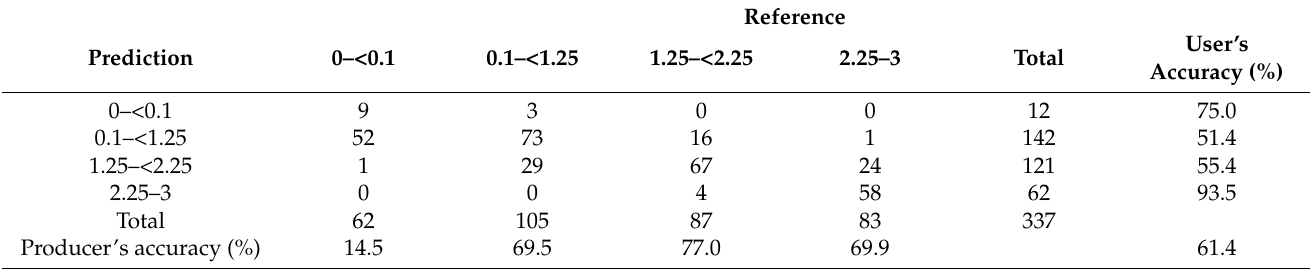
Table A9. Confusion matrix for Southwest model predicting IA CBI with Sentinel-2 dNBR with offset.